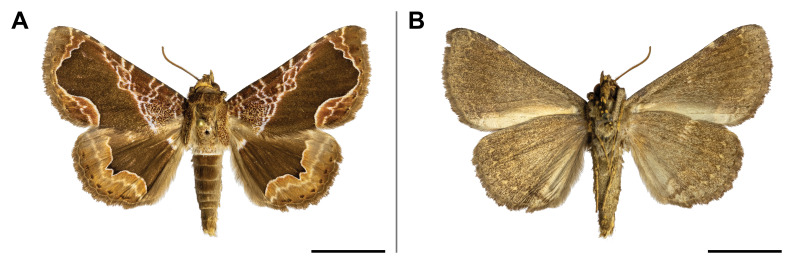
Calligraphidia
opulenta (Möschler, 1887). A. dorsal view; B. ventral view. The scale bar represents 1 cm.